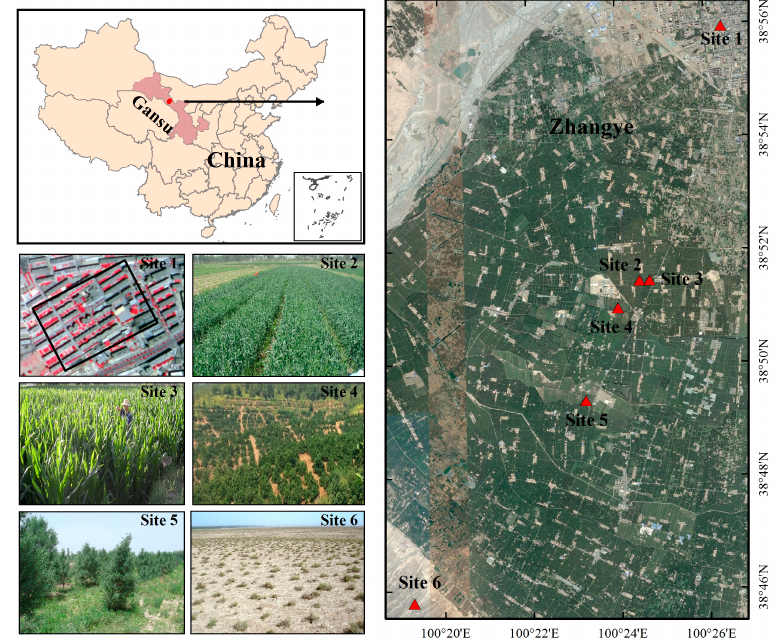
Figure 1. Locations of six sites and their false color image ( Site 1 ) from the charge-coupled device (CCD) camera and true images ( Site 2–6 ) from a digital camera. Table 1. Specifications of the six sites.